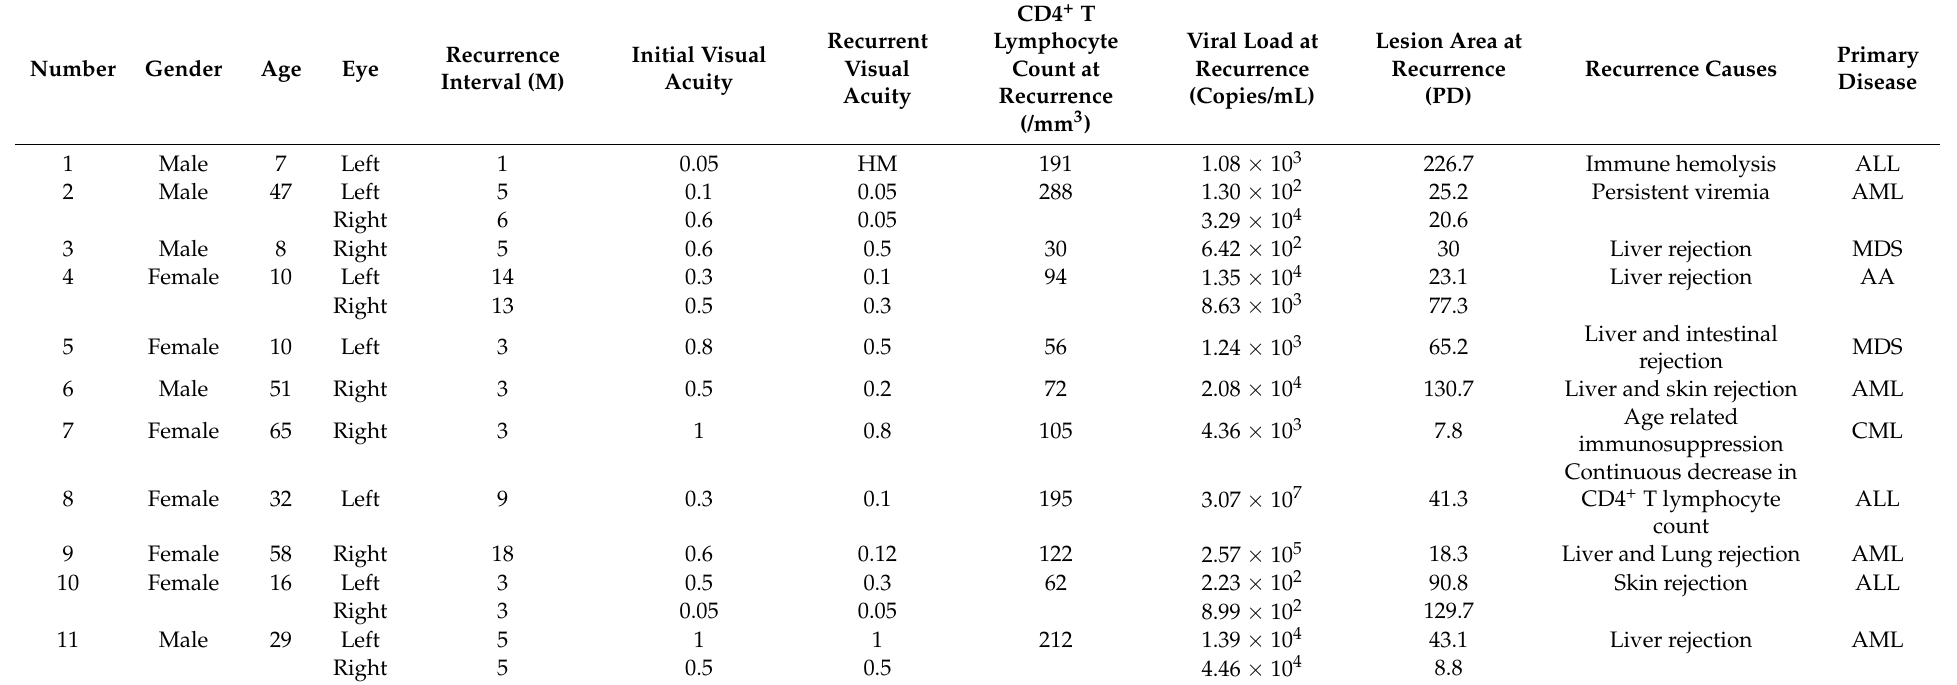
Table 2. Clinical information of patients with recurrent CMVR after